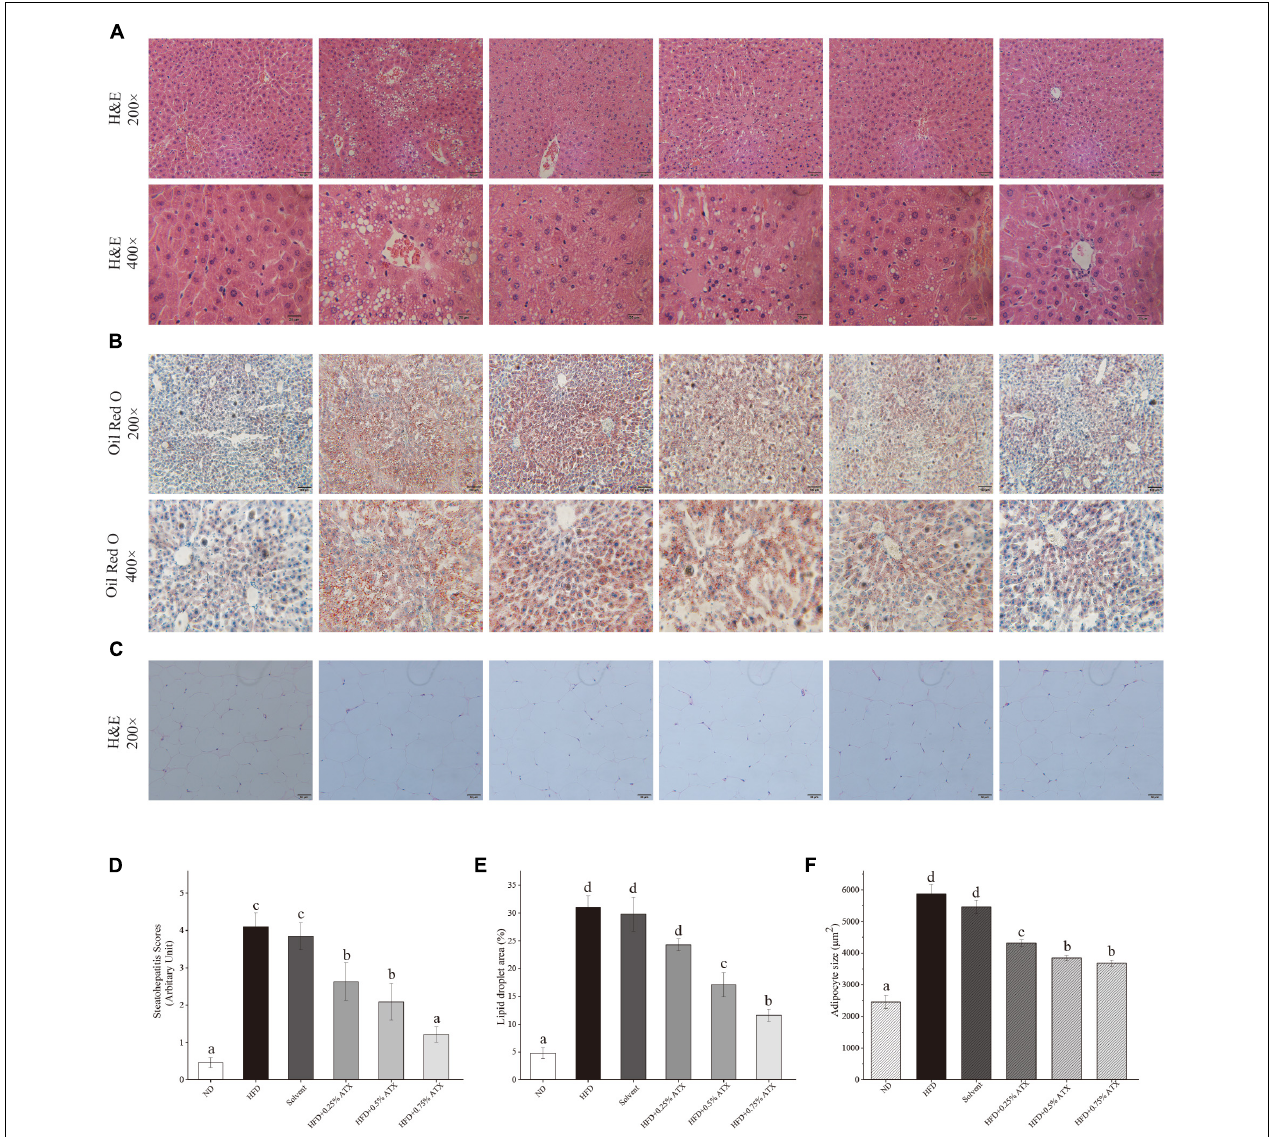
FIGURE 3 | Pathological changes of ATX on liver and epididymal fat in HFD-induced mice. (A) Liver sections stained with HE (200 × , 400 × ). (B) Liver sections stained with Oil red O (200 × , 400 × ). (C) HE-stained e-AT sections (200 × ). (D) Steatohepatitis scores. (E) Percentage of the lipid droplet area assessed by Oil red O staining. (F) Mean cell area of adipocyte in e-AT. Values are expressed as mean ± SD of triplicate ( n = 6). The different letters (a–d) indicate significant differences ( P < 0.05) according to Duncan’s multiple range test in